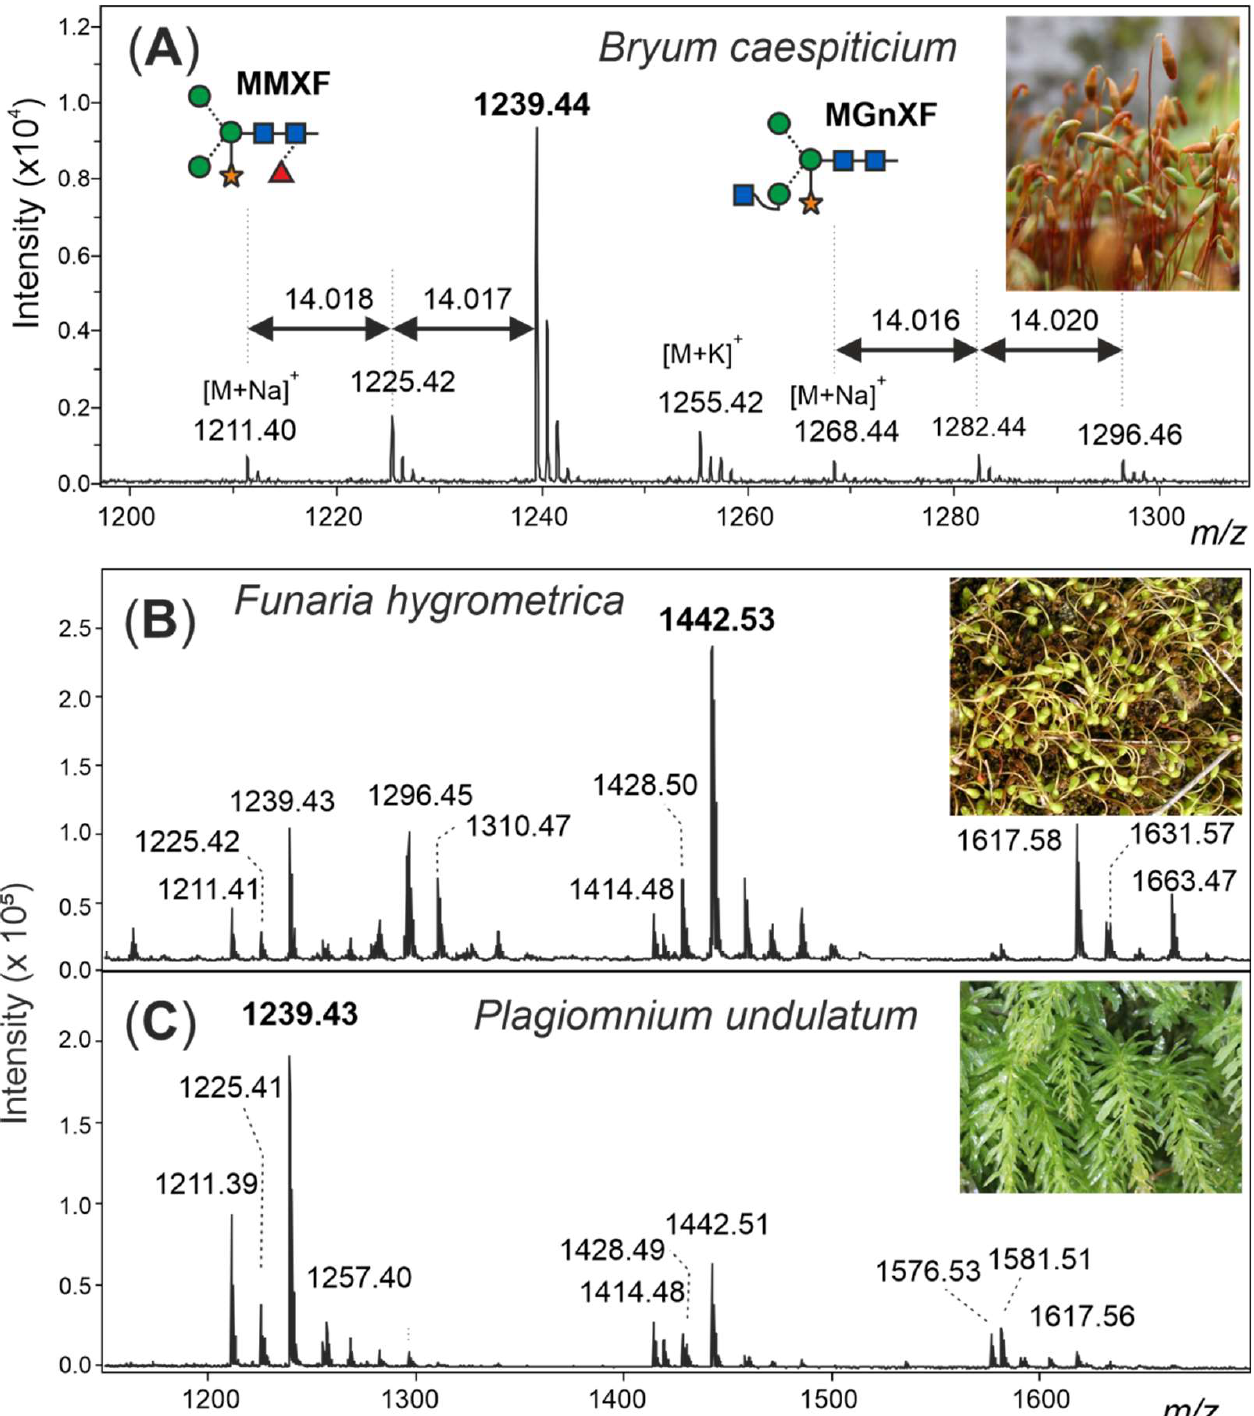
Figure 1. Demonstration of methylation of moss N-glycans. The structure abbreviations MMXF and MGnXF specify the terminal residues in a counter-clockwise manner (see also Figure S1). ( A ) Detail of the MALDI-TOF MS spectrum of N-glycans from the sporangia of Bryum caespiticium showing 14.02 Da increments. Section of the MALDI-TOF spectra of N-glycans from Funaria hygrometrica ( B ) and Plagiomnium undulatum ( C ) showing the different dominant complex-type N-glycans and their methylation. Complete spectra of all mosses analysed can be found in the Supporting Information (Figures S2 and